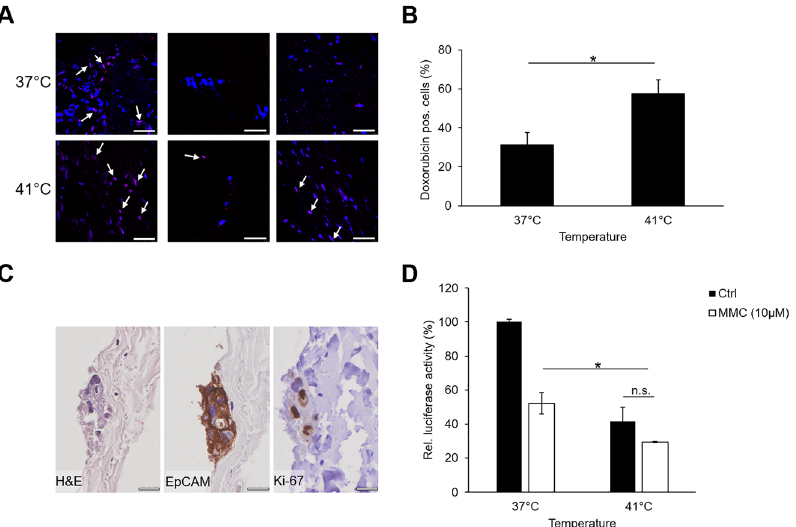
Figure 5: Ex vivo peritoneal model as a model system for hyperthermal chemotherapeutic treatment. (A) Doxorubicin immunofluorescence (red) of the ex vivo peritoneal model treated with 10 µM doxorubicin for 90 min at 37 ° C or 41 ° C; doxorubicin (red), nuclei (blue); white arrows indicate doxorubicin-positive cells in three representative images; scale bar, 40 µm. (B) Percentageofdoxorubicin-positivecellsfollowingtreatmentat37 ° Cor41 ° C(n=3;two-sided,pairedStudent'sttest:p=0.007).(C)Coculture ofHT29-GFP/luciferasecellswithhumanperitoneum.EpCAMandKi-67stainingsonday6reveallivingandproliferatingcancercells;Scalebar 20 µm. (D) Treatment with 10 µM MMC for 90 min at 37 ° C or 41 ° C reduces the amount of living HT-29-GFP/luciferase cells 3 days after treatment;shownisonerepresentativeofatleastthreeindependentexperimentsperformedintriplicates;signi fi cancewascalculatedusinga two-sided paired Student ’ s t test;